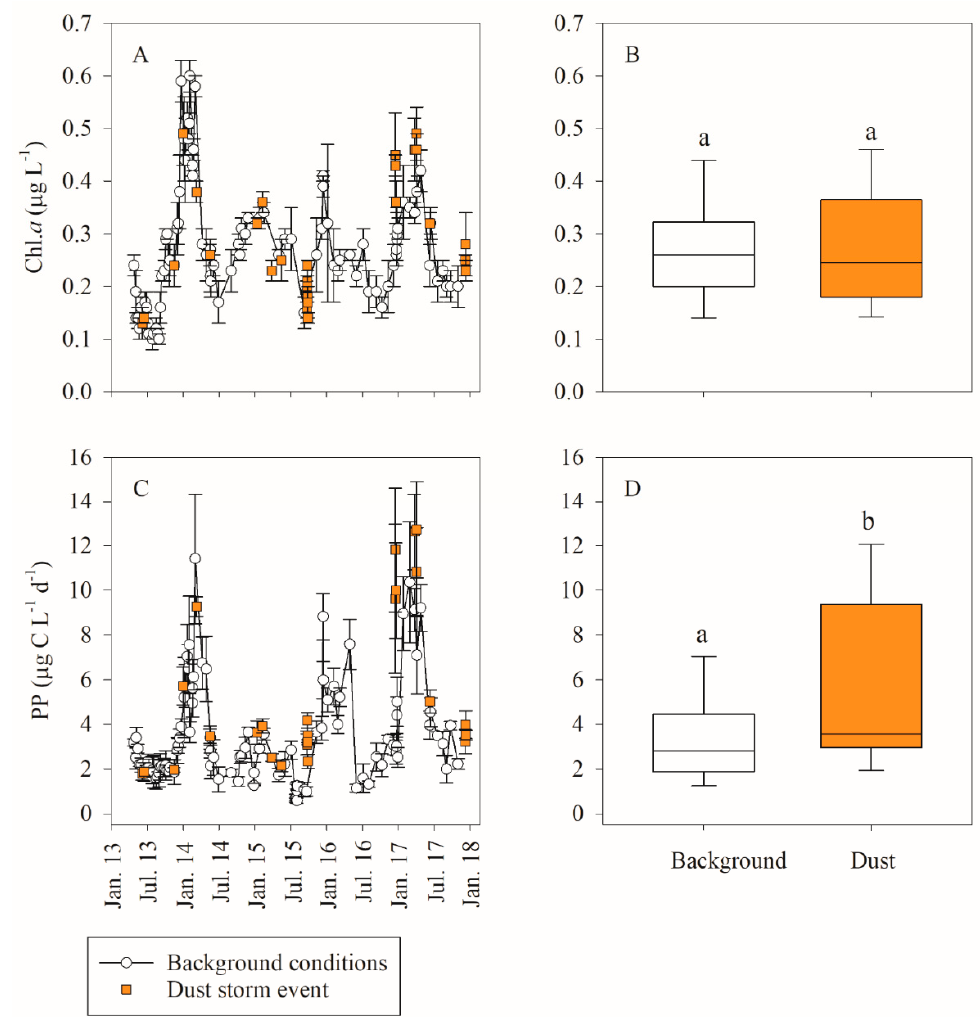
Figure 2. Surface (1–2 m) ( A , B ) Chl. a temporal variability and distribution and ( C , D ) primary production (PP) variability and distribution, respectively, at the coastal SEMS, 2013–2017. Measurements were taken during “typical” days (white, Supplementary Table S1, n = 89) and dust storms (orange, Supplementary Table S2, n = 29). Box-whisker plots show interquartile range (25th to 75th percentile) of the dataset. Horizontal lines within the boxes represent median value. Letters above the box-plots represent significant differences ( t -test, p < 0.05) for mean values between background and dust measurements.